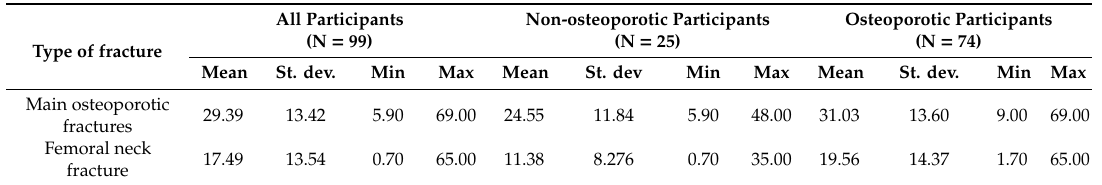
Table 5. The ten-year fracture risk, according to the FRAX (%).